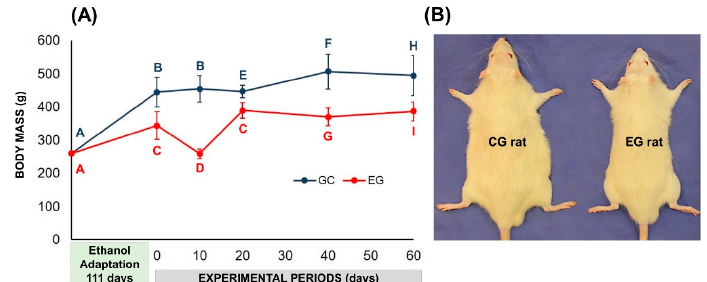
Figure 2. ( A ) Graphic representation of body mass (g) during ethanol adaptation-induced dependence (111 days) and experimental periods of control (CG-water ad libitum) and experimental (EG-ethanol solution ad libitum) groups. ( B ) Comparison between body masses of CG vs. EG showing the negative e ff ect of alcohol. Di ff erent letters p < 0.05 (independent t-test and paired t-test showed interaction between group and